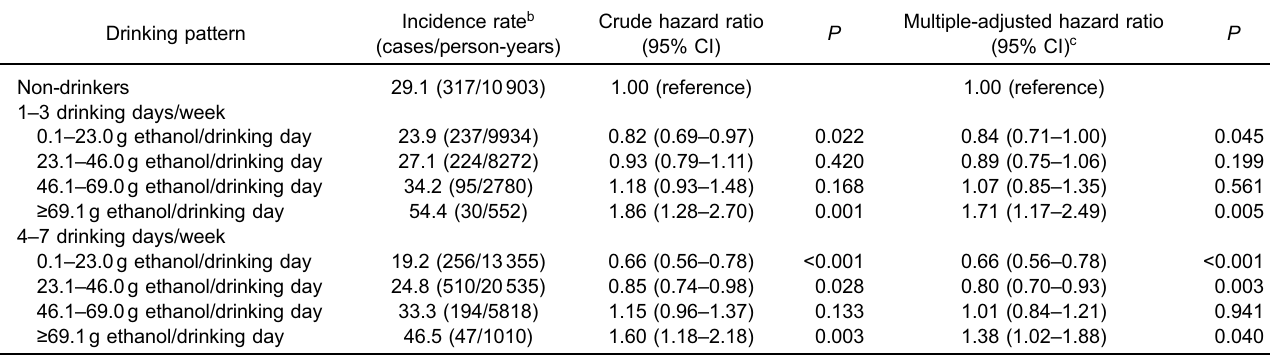
Table 3. Incidence rates and hazard ratios for any proteinuria a according to the drinking pattern Drinking